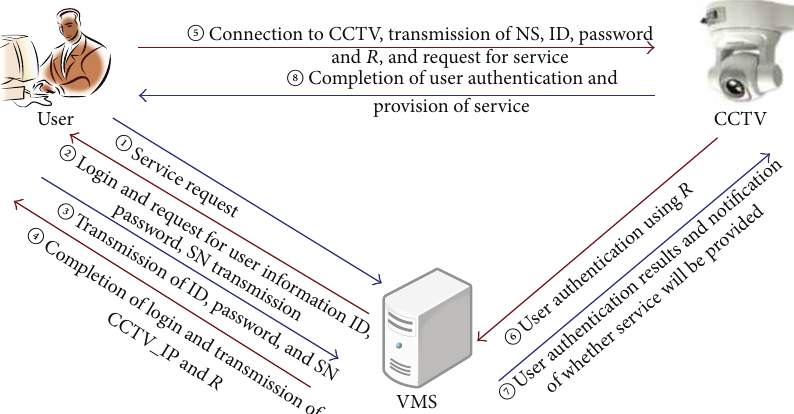
Figure 6: Overall composition diagram.